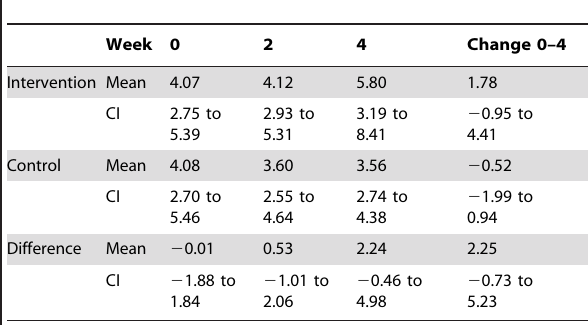
Table 3. Development of FMD in percent during the